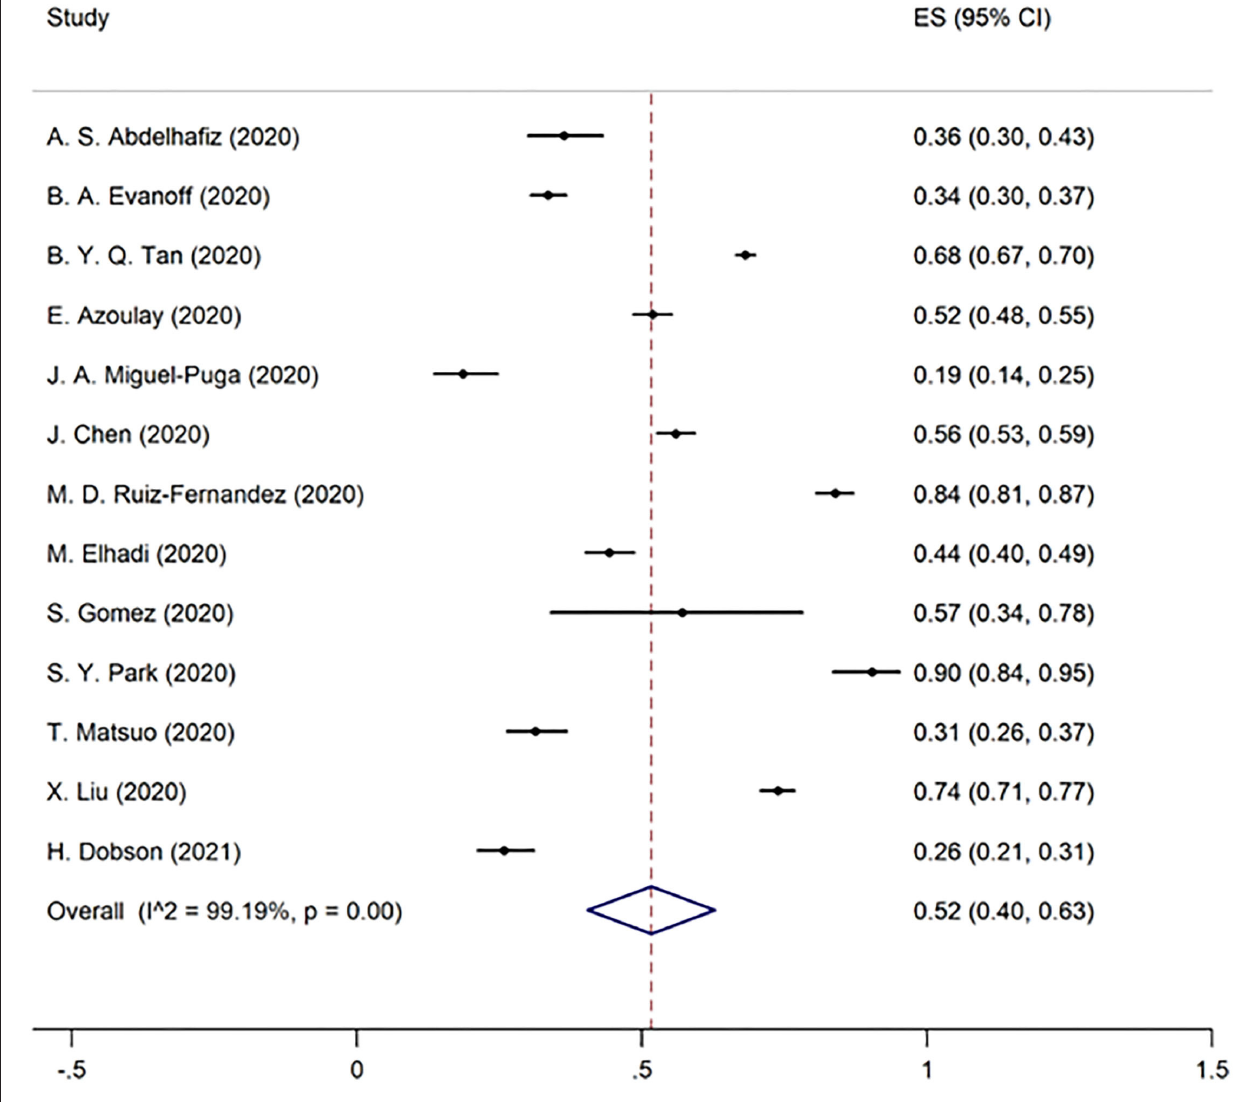
FIGURE 4 | The pooled prevalence of depersonalization in included